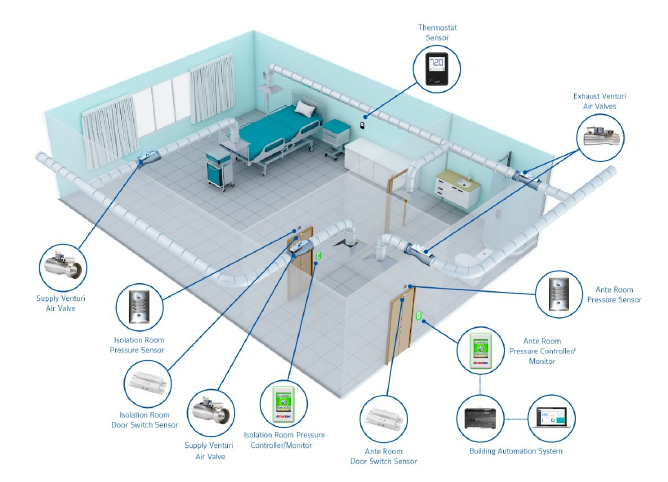
Figure 8. Different environment sensor